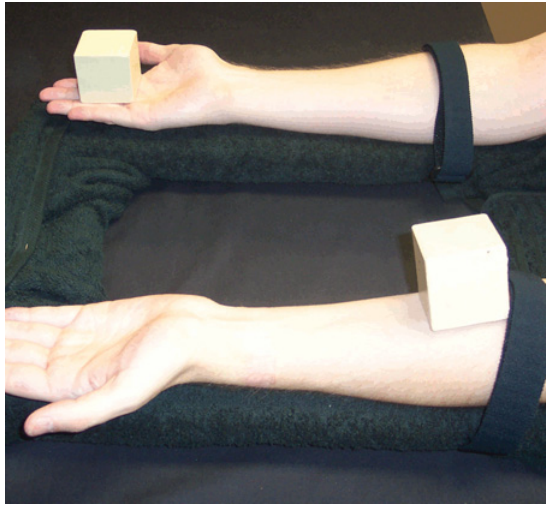
Fig 13. Action block's location at the end of Condition 4